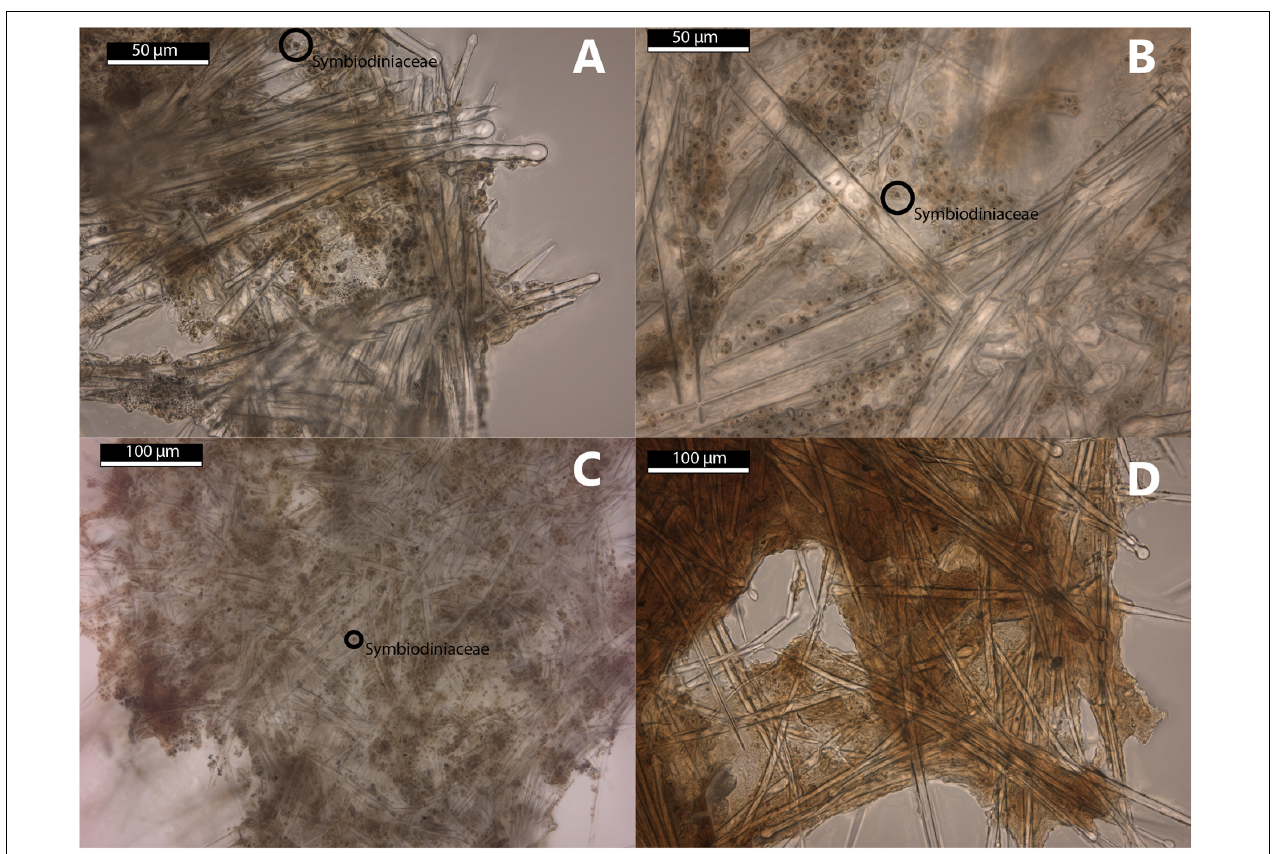
FIGURE 2 | Thick sections of selected Clionaidae species collected in this study. (A–C) Symbiodiniaceae present in ectosomal tissue of the sponge host. (A) Cliona thomasi (RMNH.POR.11777) (B) Spheciospongia maeandrina (RMNH.POR.11795) (C) Spheciospongia digitata (RMNH.POR.11784) (D) Cliona utricularis (RMNH.POR.11778), no Symbiodiniaceae